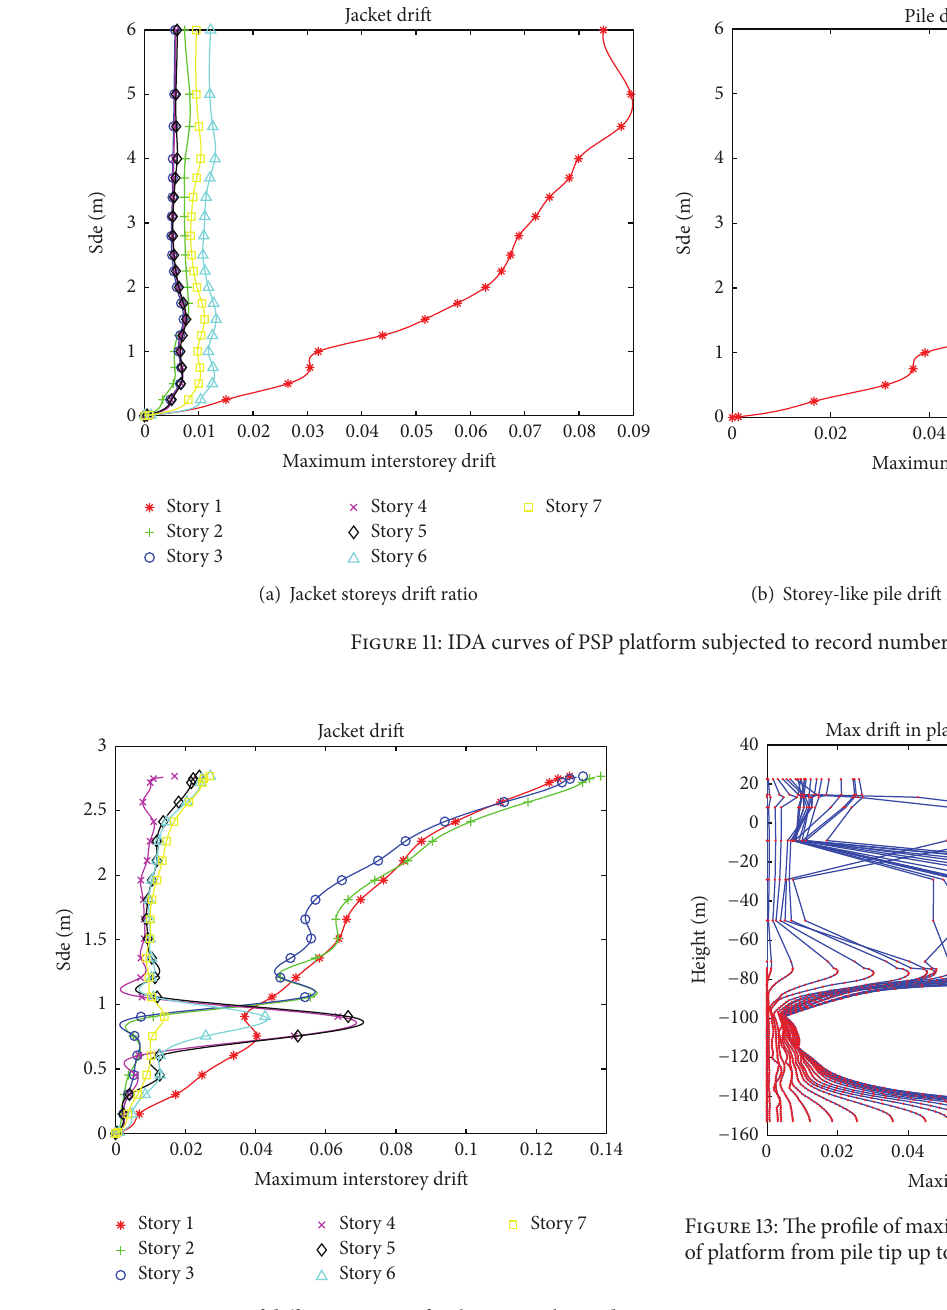
Figure 12: IDA curves of different stories of jacket part subjected to record number 4.